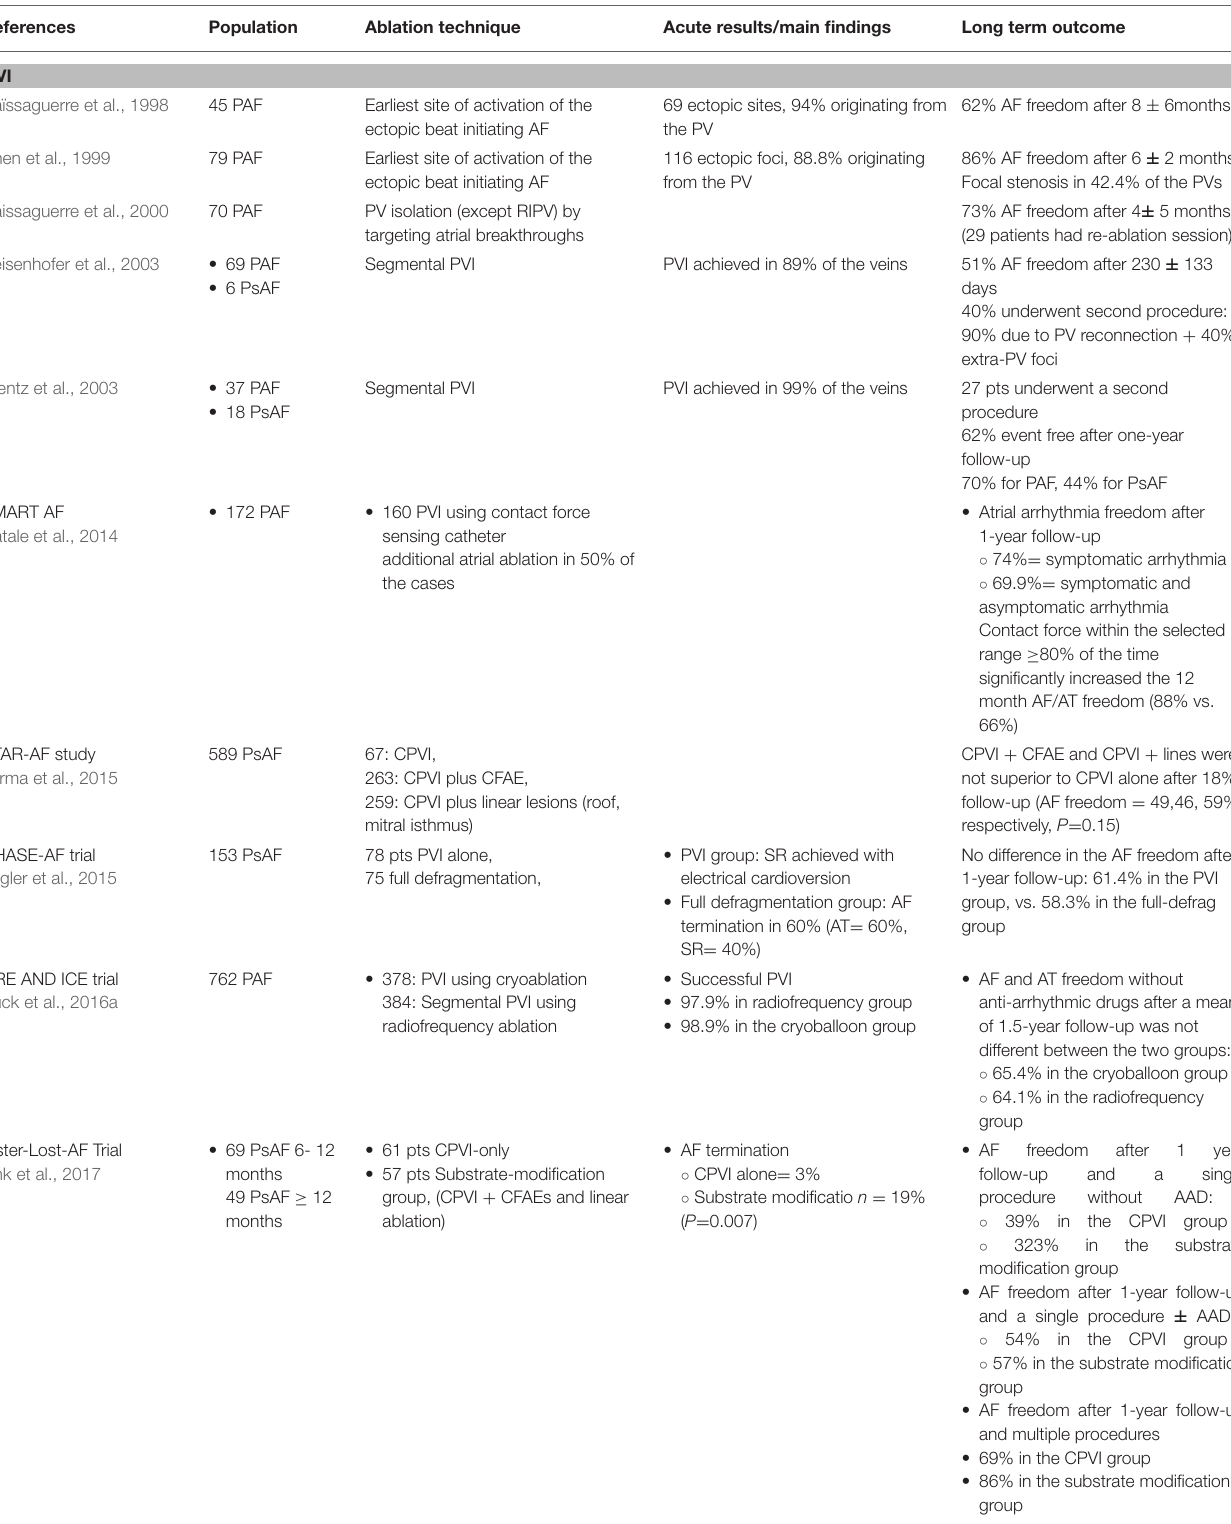
TABLE 1 | Summary of the different approaches of percutaneous ablation of